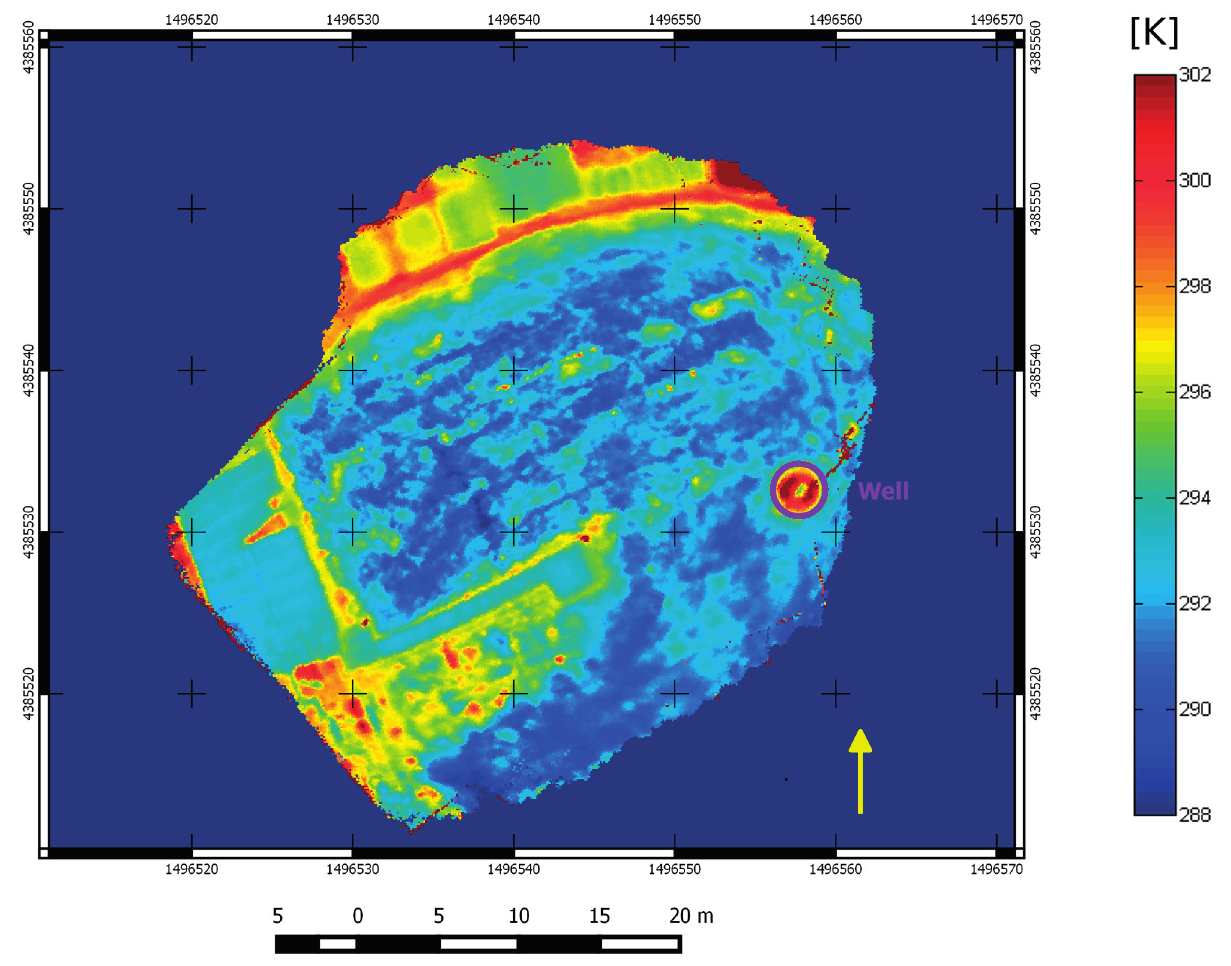
Figure 6. The thermal map of apparent intercept temperature (in Kelvin degrees), resulting from the merging of many thermograms and processing temperature over